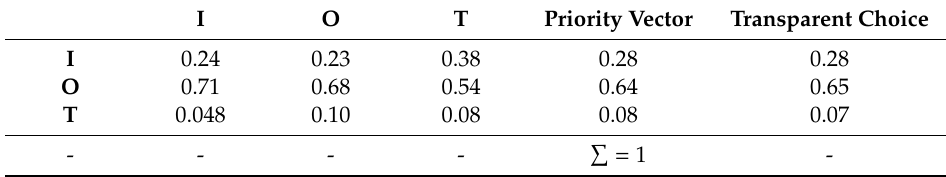
Table A5. Synthesised matrix of the three main classes of probable causes.